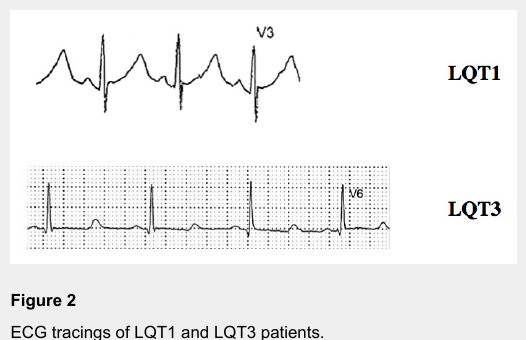
ECG tracings of LQT1 and LQT3